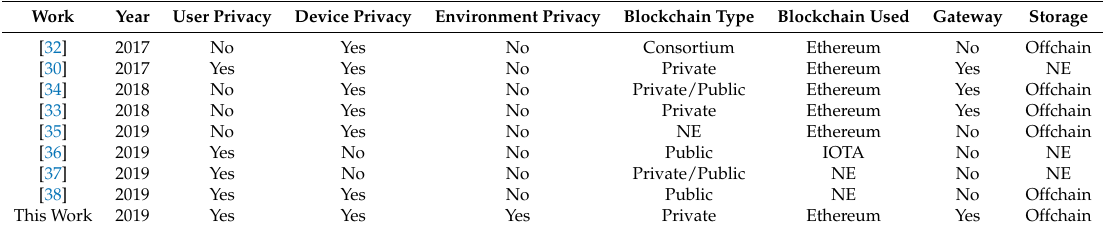
Table 1. Related Work.